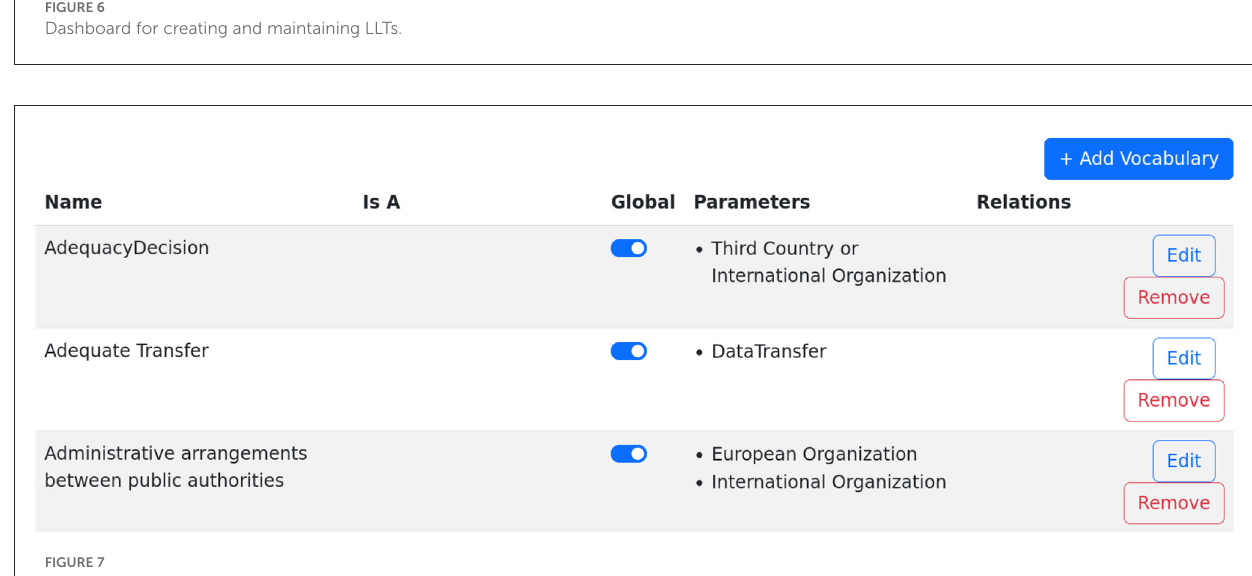
FIGURE6 Dashboard for creating and maintaining LLTs.